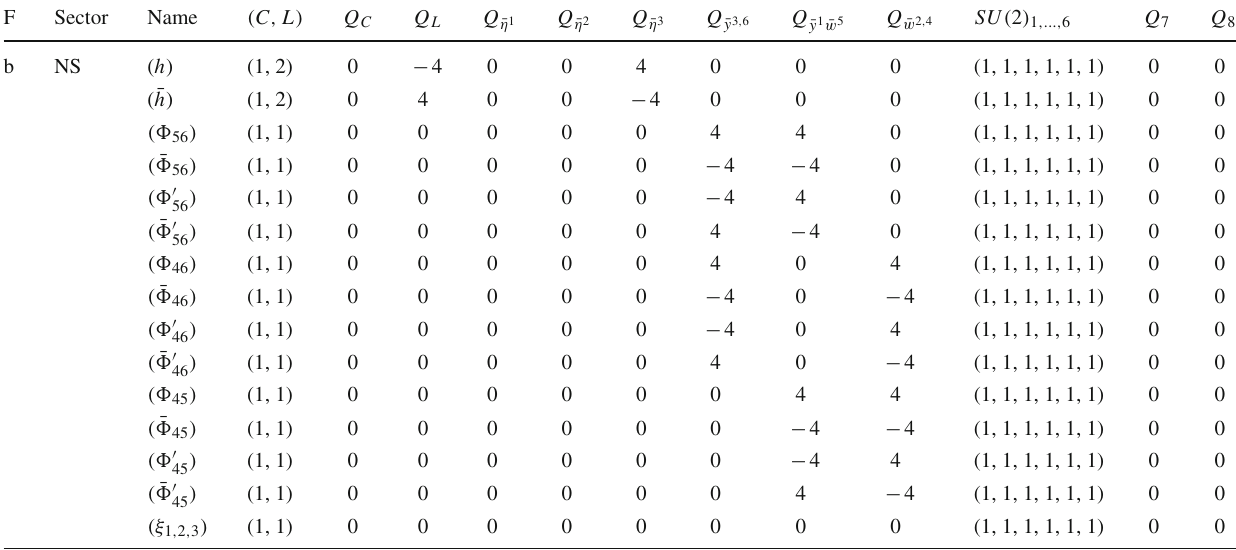
Table 1 The untwisted Neveu–Schwarz scalar states. All charges are multipled by 4 F Sector